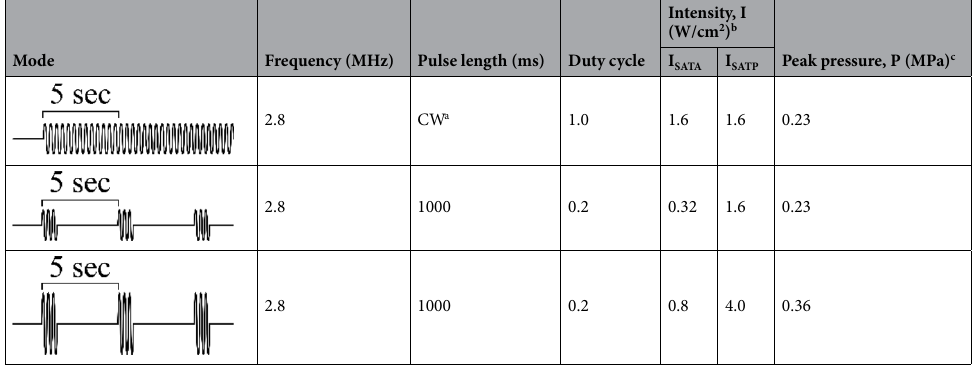
Table 1. Summary of the US parameters. a Continuous wave bursts with three 2:2 min on:off cycles. b Determined by measuring radiation pressure. c Calculated by using the equation I = P 2 /2ρc, where ρ = density, and c = speed of